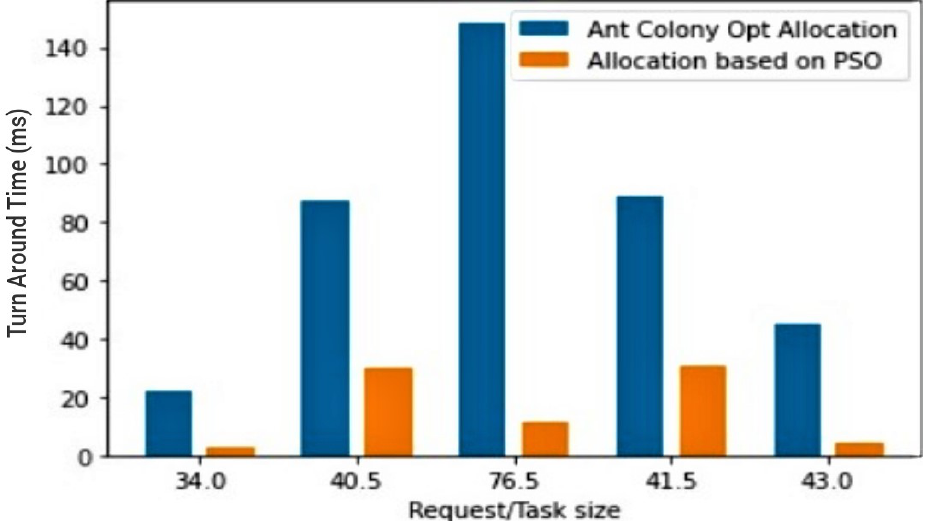
Figure 4. Ant Colony vs. PSO clustering